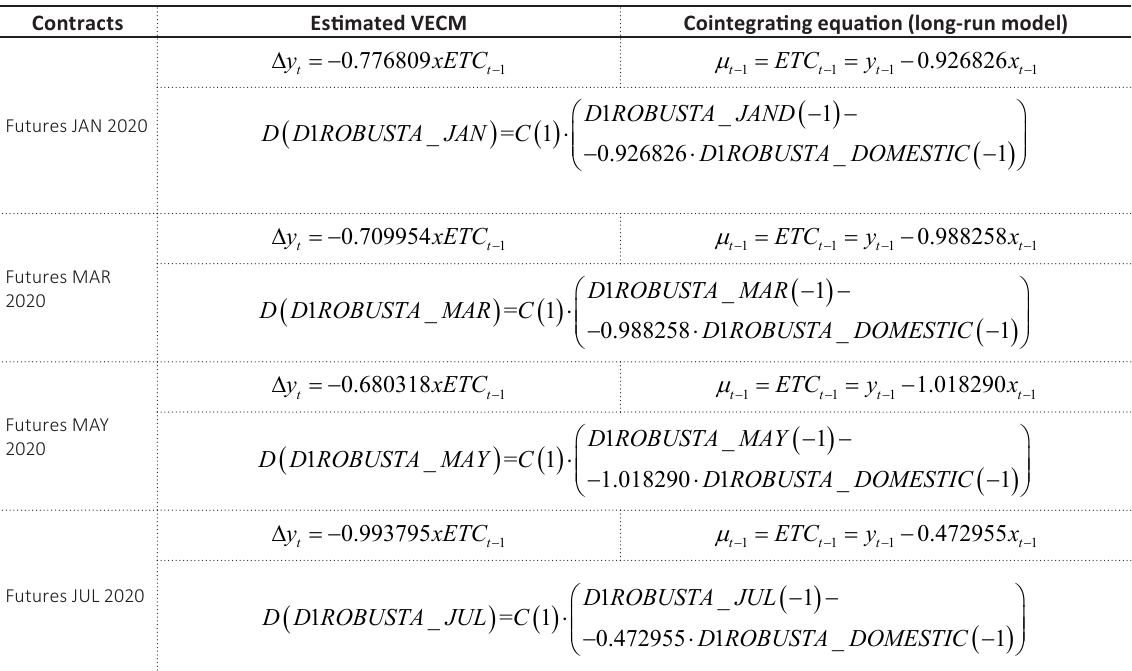
Source: Authors’ calculation.